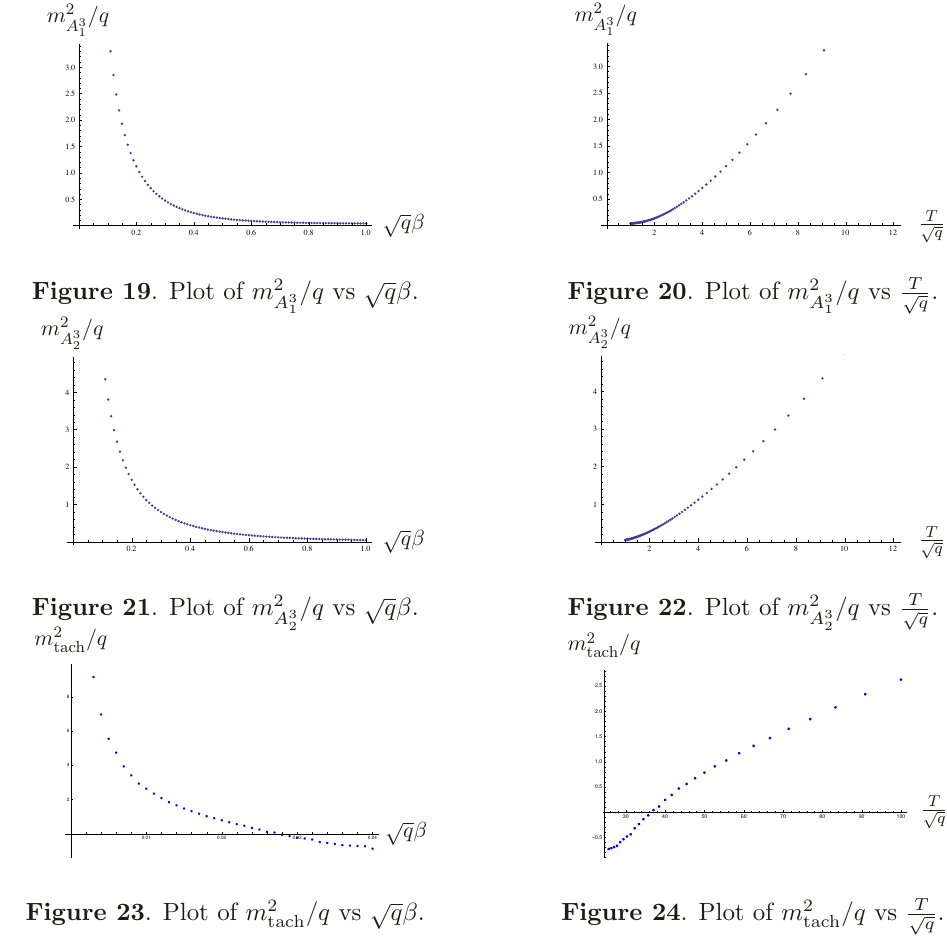
Figure 23 . Plot of m 2